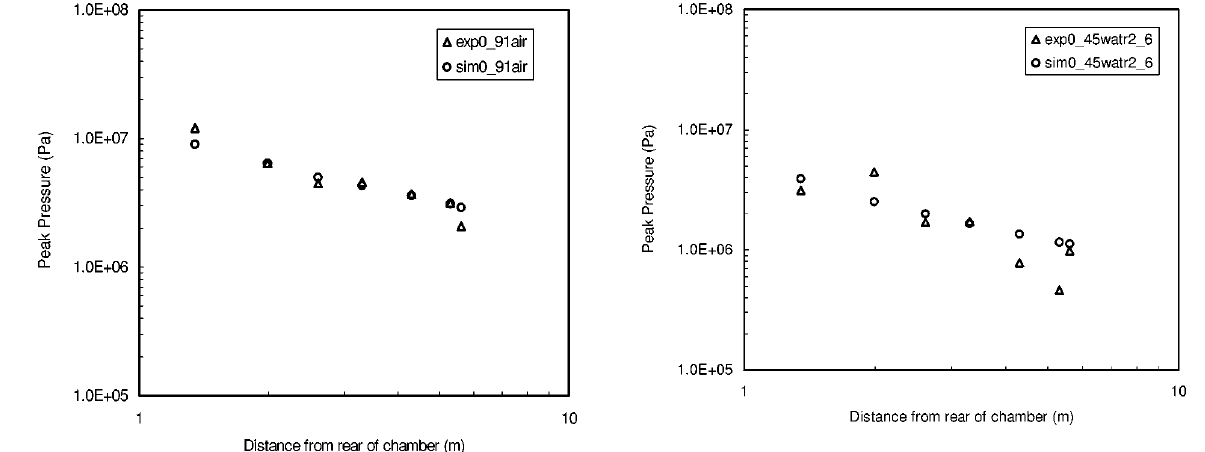
Fig. 6. Comparison between experiment and computation for 0.45 kg C4 charge detonation with water ( R = 2 :